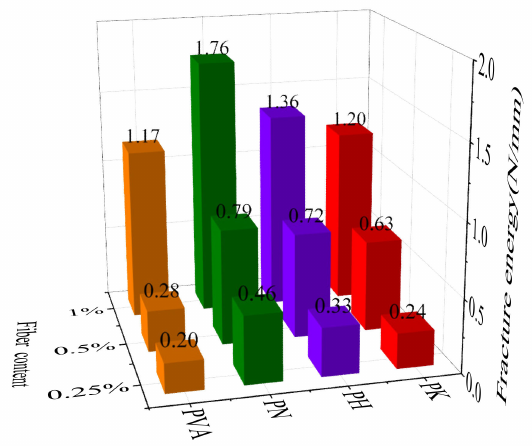
Figure 6. Fracture energy of cemented soil before and after